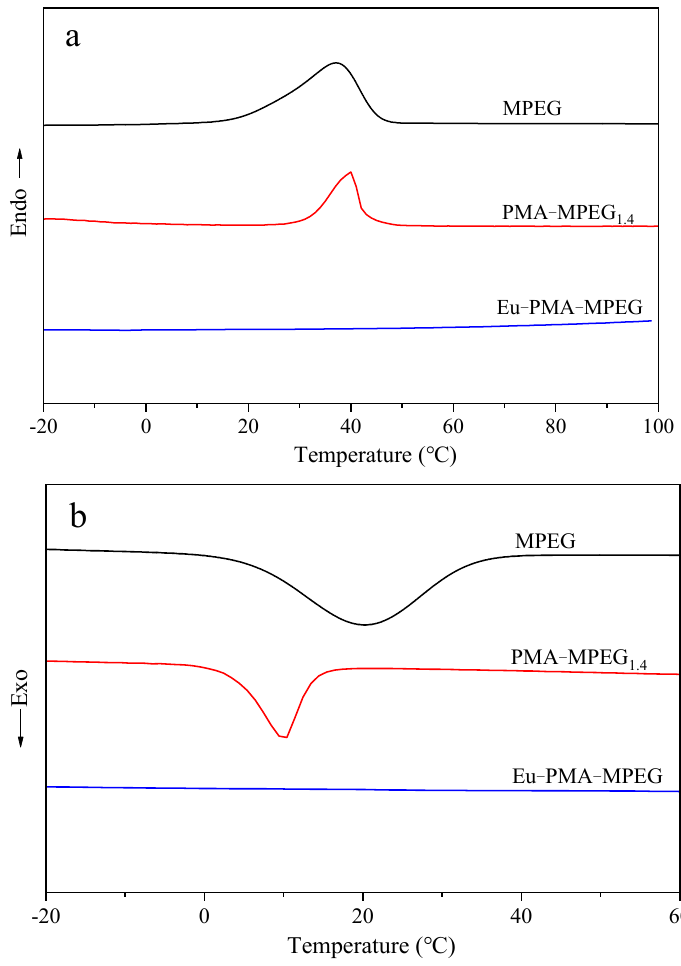
Figure 3. The second heating curves ( a ) and cooling curves ( b ) of MPEG, PMA-MPEG 1.4 and Eu- PMA-MPEG at a rate of 10 °C/min.